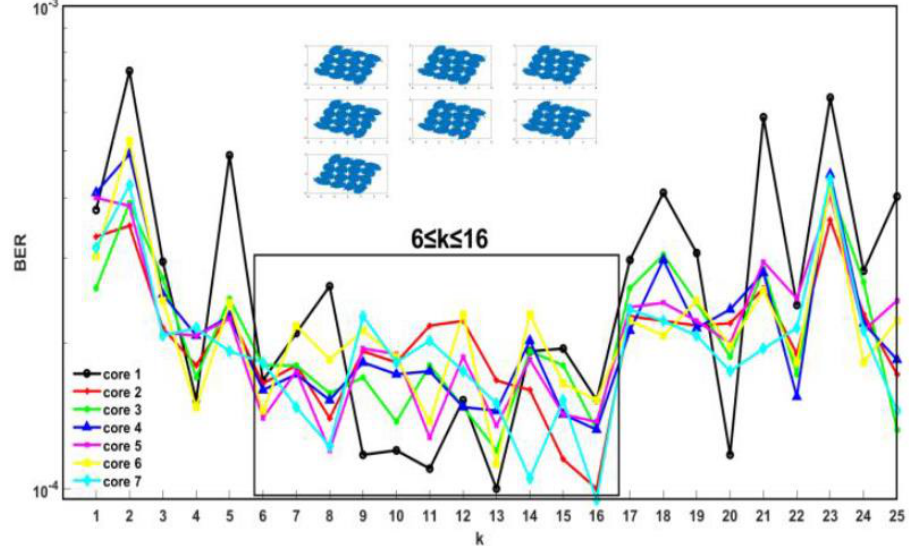
Fig. 4. Variation of BER with k value in seven-core